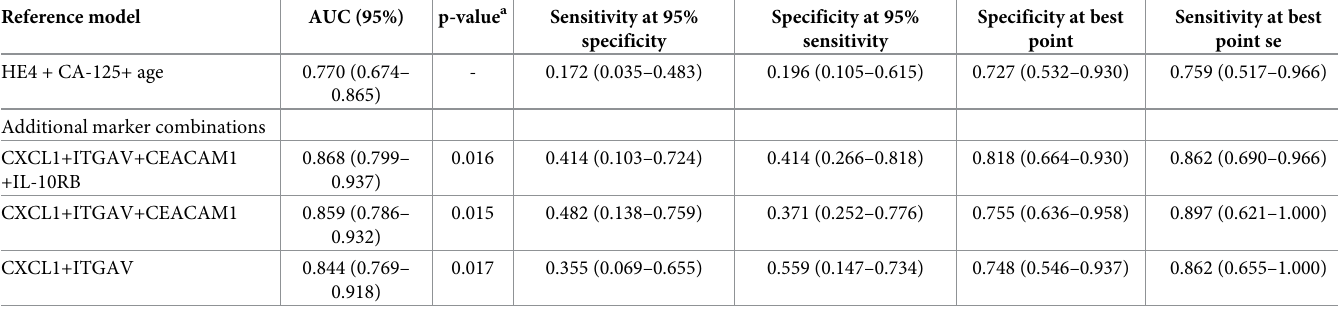
Table 9. Biomarker models, LASSO selection. Benign tumors vs. borderline + cancer.